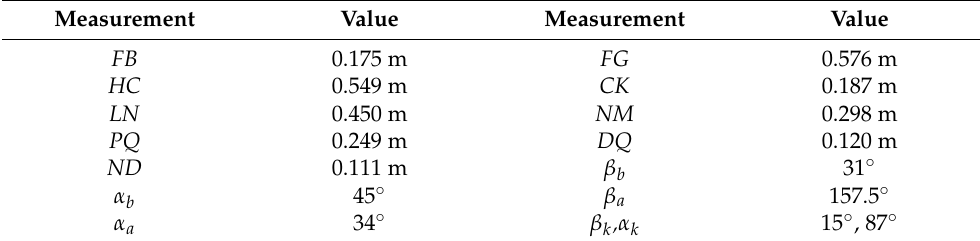
Table 1. Length and angle information of the links in Figure